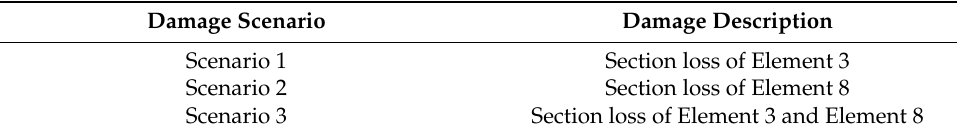
Figure 2. The schematic diagram of damages. Table 1. Damage scenarios.